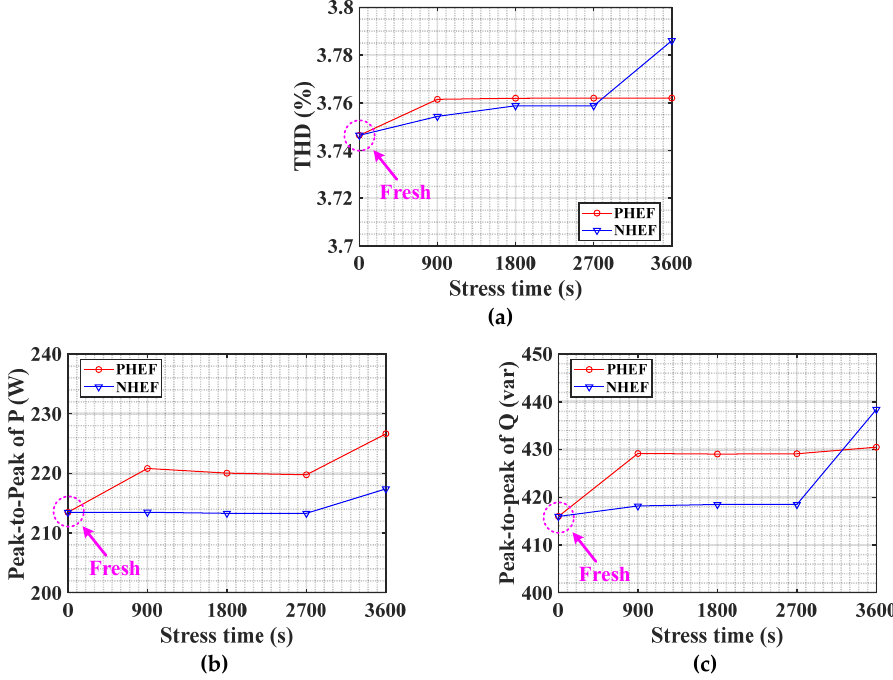
Figure 29. Performance change of voltage source inverter under HEF stress time: ( a ) THD, ( b ) peak-to-peak value of P , and( c ) peak-to-peak value of Q .